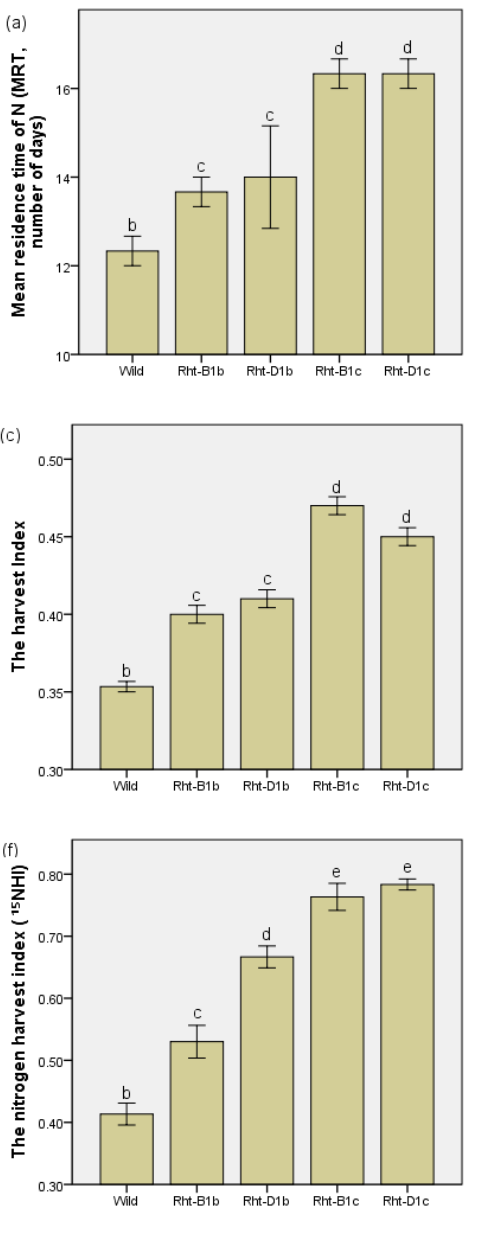
Figure 3. The effect of straw shortening on MRT of N, harvest index, and grain number on spike: ( a ) variation of MRT of N (number of days) by lines with different level of dwarfing, ( b ) variation of NUE of N (g dw mg − ¹) by lines with different level of dwarfing, ( c ) the harvest index, ( d ) grain number per spike, ( e ) thousand grain weight, and ( f ) the N harvest index. Values are means ± SE (n = 6). The bars showing the same letters indicate that their mean values do not statistically differ significantly ( p <